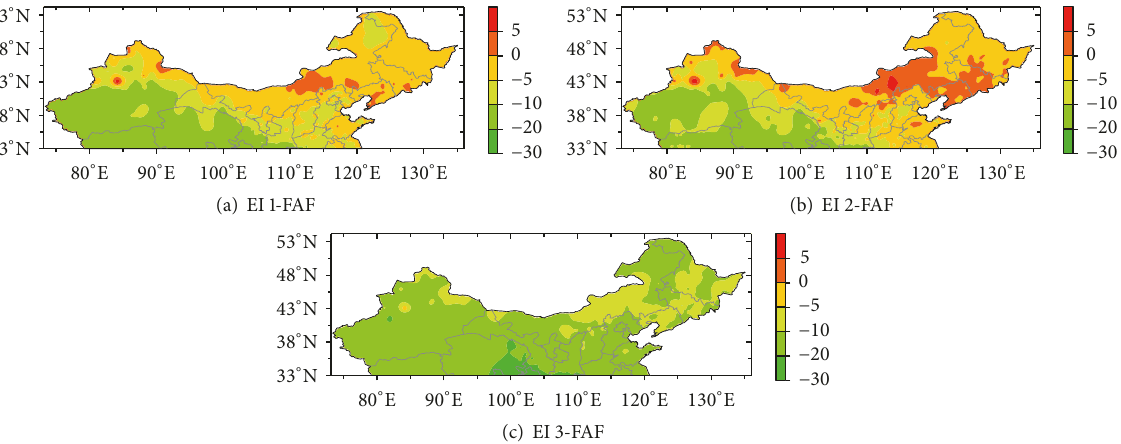
Figure 9: Average differences (days) in the end of the growing season between EI 1, EI 2, EI 3, and the first autumn/winter frost (FAF) date in northern China during